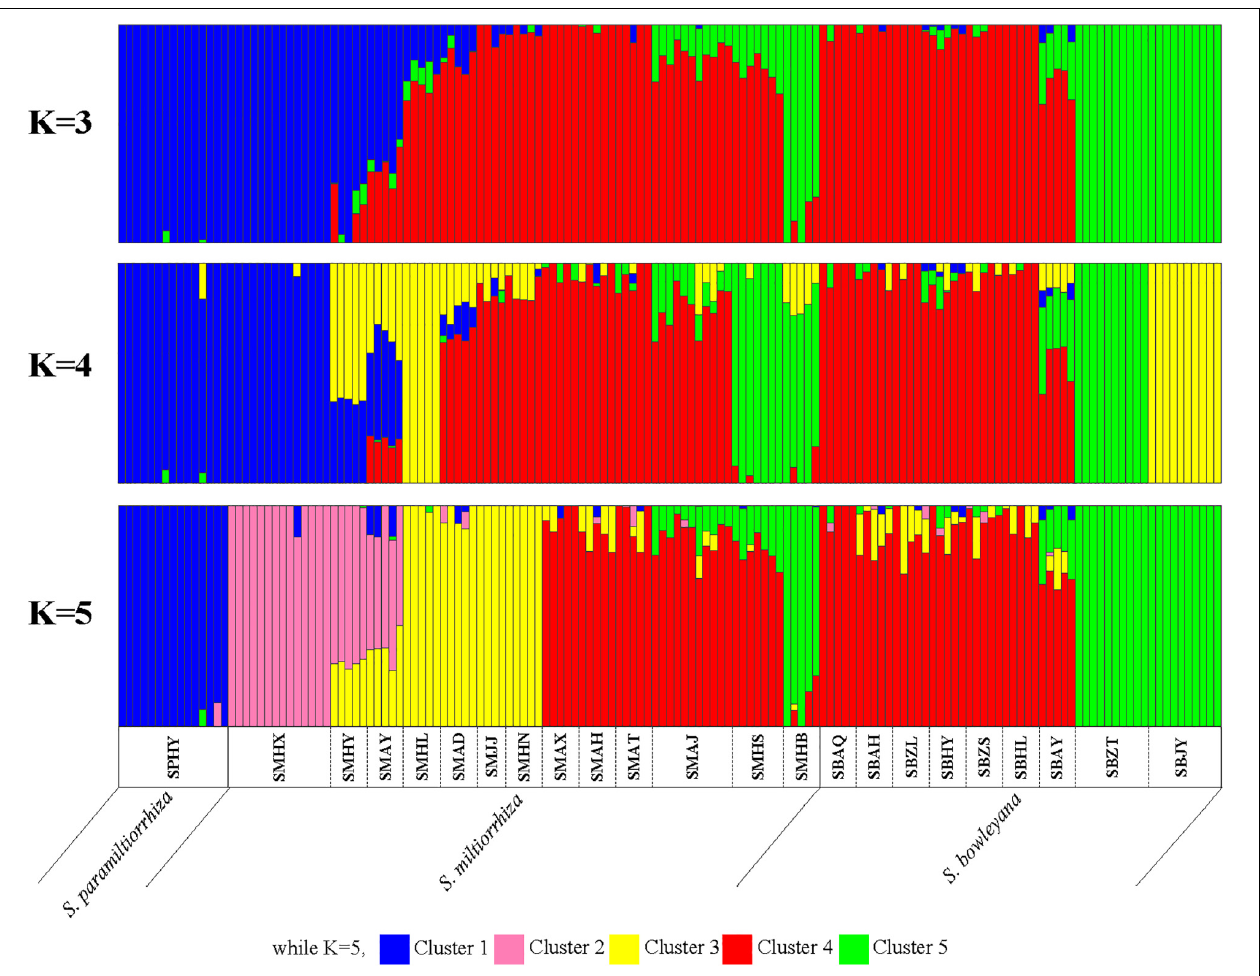
FIGURE 3 | ADMIXTURE bar graphs representing genetic clusters ( K = 3–5) of samples from the 23 sampling sites divided into three species zones. Each bar represents an individual sample and colors code membership of each individual with assigned cluster. Below the bar, the populations ID and species name were